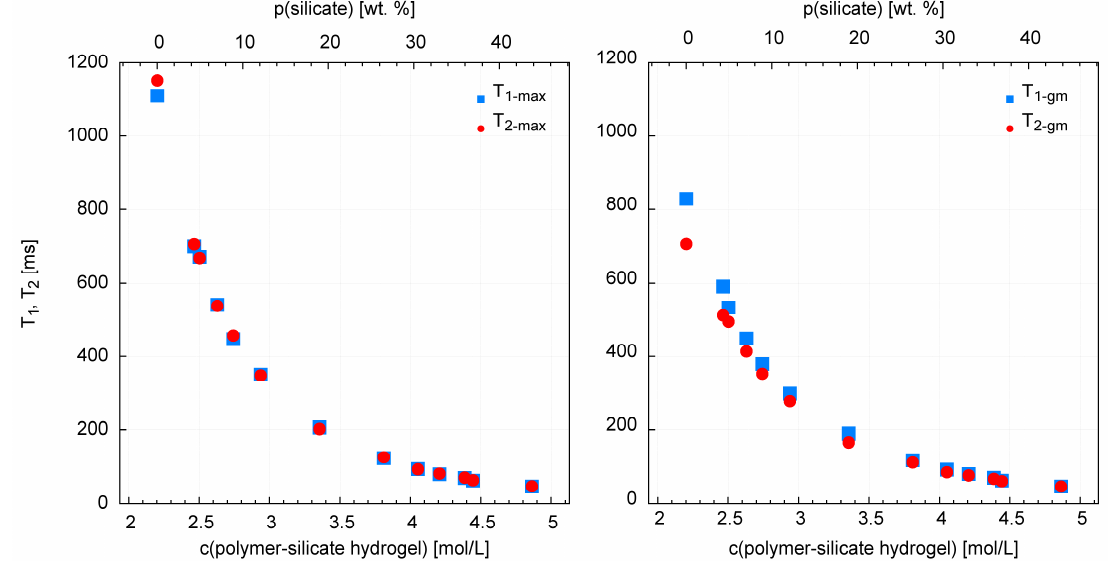
Figure 7. Relaxation times at maximum, T 1 max , T 2 max and for geometric mean, T 1 gm and T 2 gm for samples with different molar concentrations of polymer-silicate hydrogel. The left most point corresponds to a pure acrylate solution, while the one on the far right corresponds to a sodium water glass solution. From left to right, the acrylate content gradually decreases and the sodium water glass content in the solution increases.